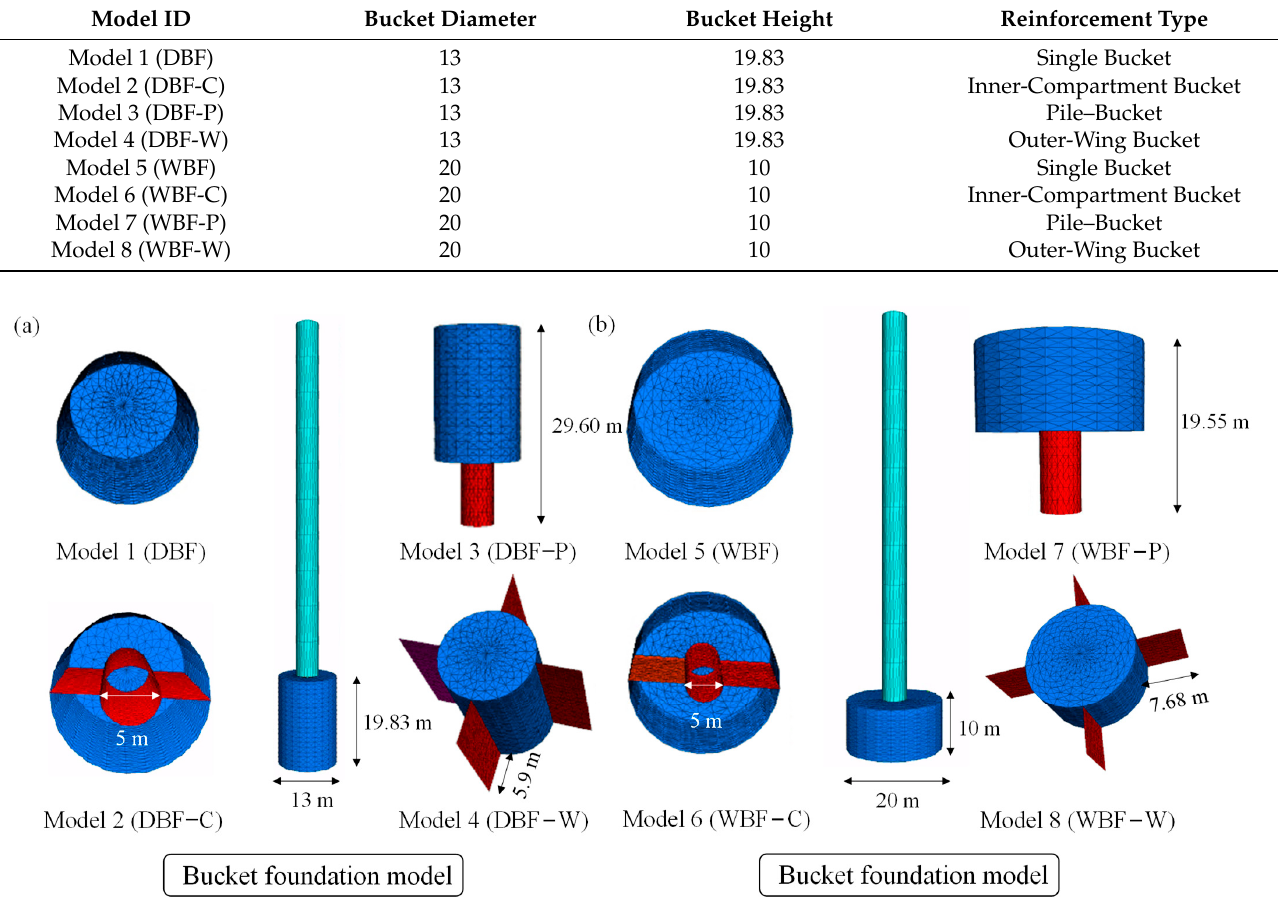
Figure 1. Bucket foundation model: ( a ) deep bucket foundation; ( b ) wide bucket foundation.